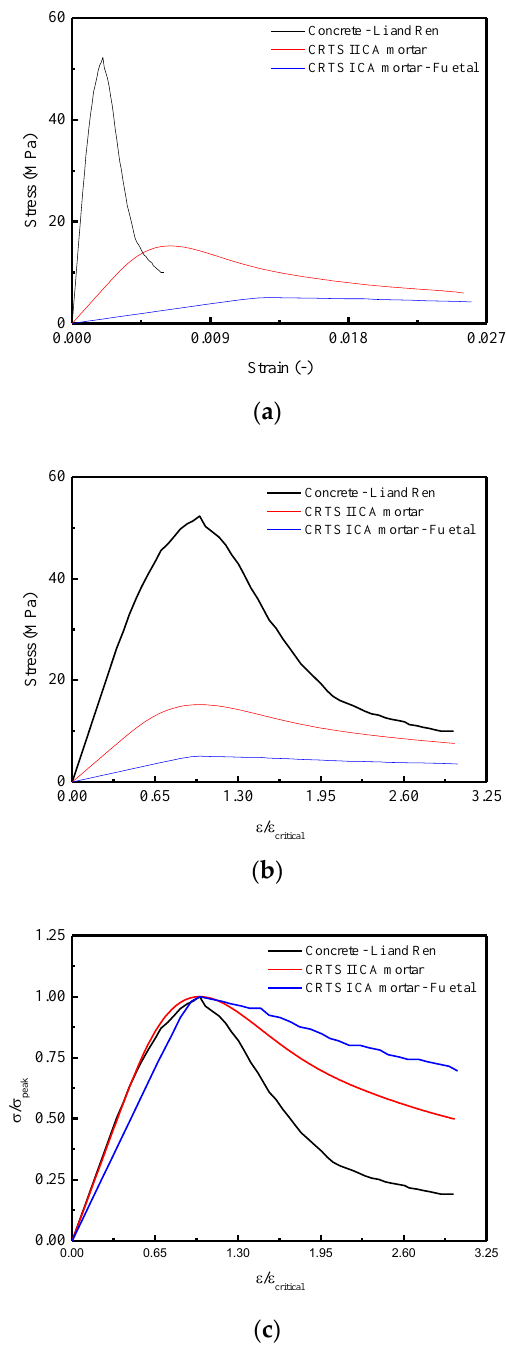
Figure 16. Comparisons of the mean constitutive relationships among China Railway Track System (CRTS) CRTS II CA mortar, CRTS I CA mortar, and concrete under compression in terms of: ( a ) 𝜎 - 𝜀 curve; ( b ) 𝜎 - 𝜀 / 𝜀 𝑐𝑟𝑖𝑡𝑖𝑐𝑎𝑙 curve; ( c ) 𝜎 / 𝜎 𝑐𝑟𝑖𝑡𝑖𝑐𝑎𝑙 - 𝜀 / 𝜀 𝑐𝑟𝑖𝑡𝑖𝑐𝑎𝑙 curve.